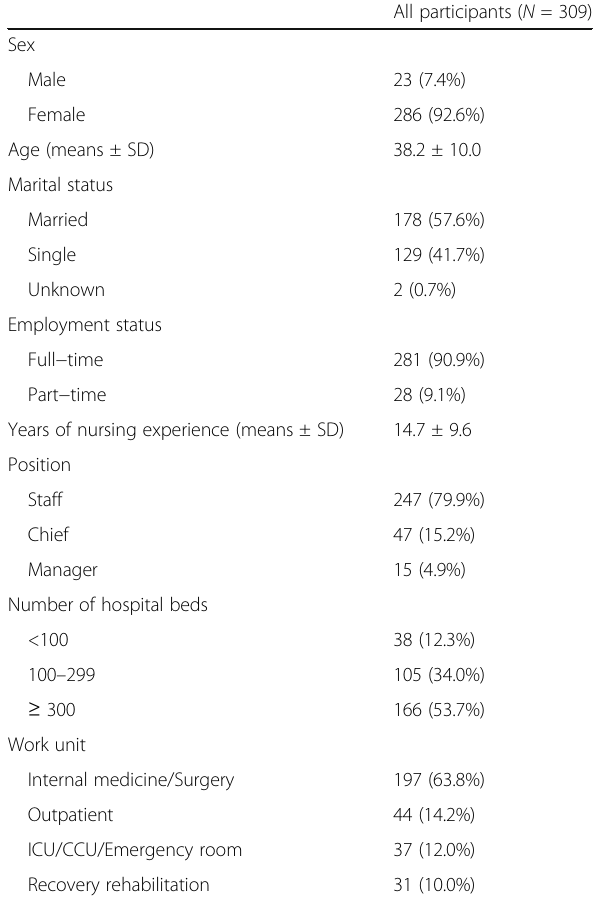
Table 1 The demographics of the participants in the first survey All participants ( N =